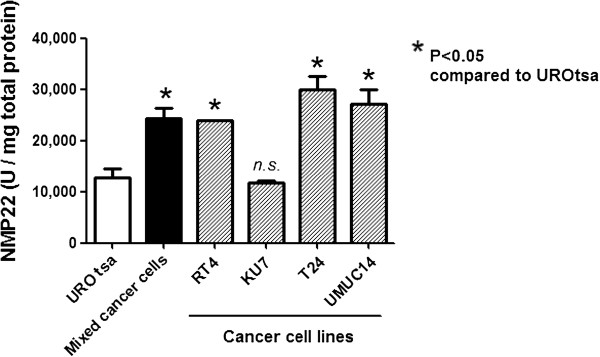
NMP-22 ELISA assay of human bladder cell lines. The human bladder cancer cell lines, RT4, T24 and UM-UC-14 had elevated NMP-22 levels compared to the benign UROtsa human cell line. Levels of NMP-22 in the KU-7 human bladder cancer cell line were not elevated compared to UROtsa. Significance (p < 0.05) was assessed by Student t test. n.s., not significant.